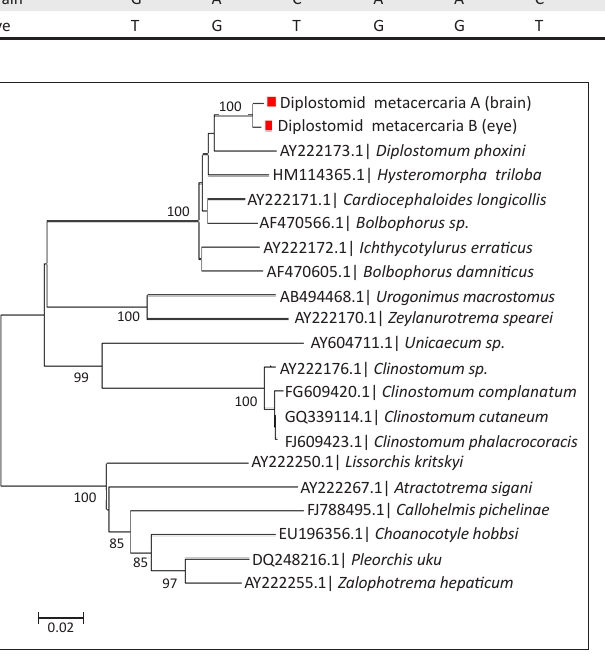
TABLE 1: Differences in the nucleotides across the genomes of two diplostomid metacercariae from the eyes of Tilapia sparrmanii and Pseudocrenilabrus philander , and the brain cavity of Clarias gariepinus . Nucleotides